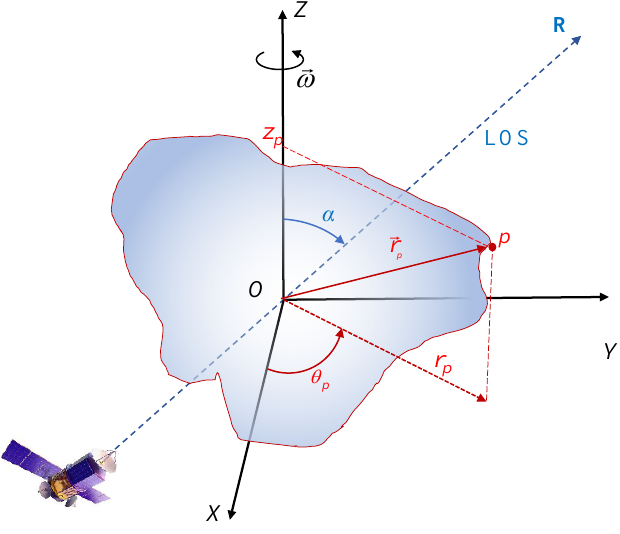
Figure 1. Coordinate system and notation for a spinning